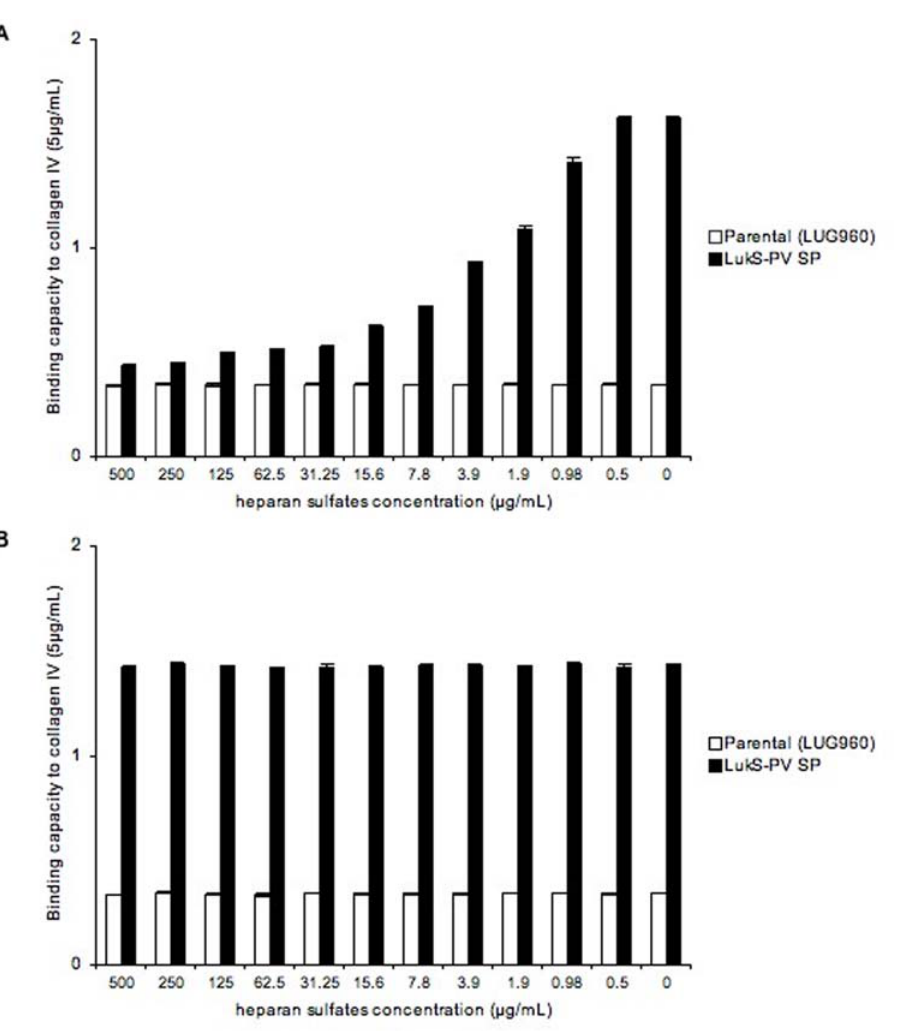
Figure 3. Inhibition of adhesion to collagen IV by heparan sulfates. Isogenic strains of Staphylococcus aureus examined for their binding capacity (Y-axis, absorbance reading at 540 nm) to collagen IV (Sigma) coated on 96-well plates, at concentrations of 5 m g/mL. Heparan sulfates were added at decreasing concentrations (X-axis) to the bacteria before the adhesion assay (panel A), or after the preincubation of the bacteria with collagen IV (Sigma) (panel B). Parental (LUG960) indicates the genetic background in which the genetic modifications were made; LukS-PV SP, parental carrying a plasmid encoding the LukS-PV signal peptide. The vertical lines indicate the standard deviation.